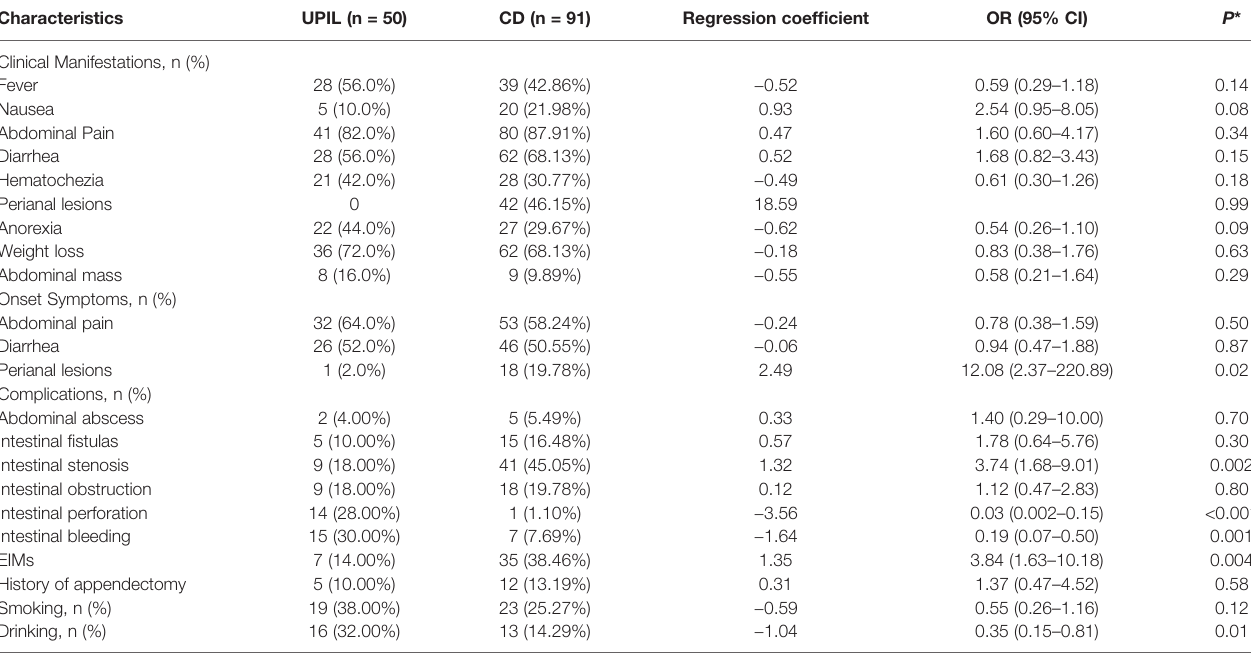
TABLE 2 | Clinical Characteristics of Participants with Crohn ’ s disease or Ulcerative Primary Intestinal Lymphoma.